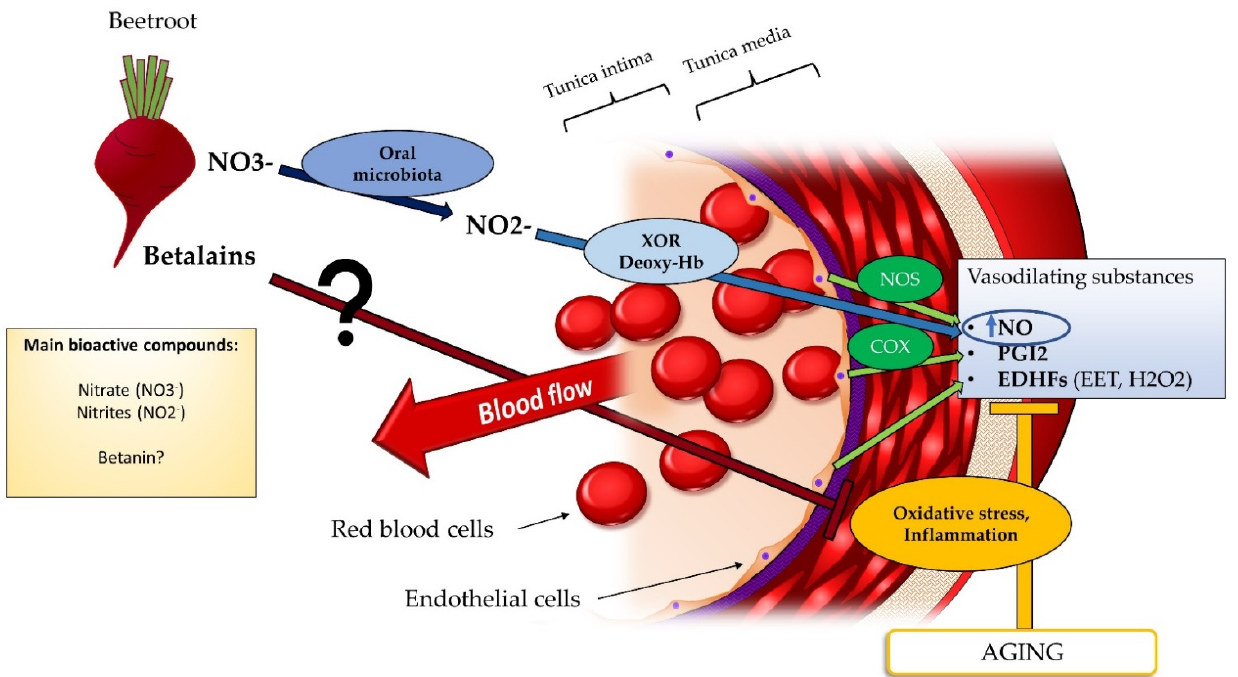
Figure 2. Schematic representation of the mechanism of action of beetroot in the increase of vascular function in older subjects. Endothelial cells produce vasodilating substances through different enzymes in response to physiological stimuli. Aging can be associated with high levels of oxidative stress and inflammation that cause an impairment of those vasodilating substances. Dietary NO3 − from nitrates rich vegetables, such as beetroot, can acutely contribute to replenish the pool of NO in case of impairment thanks to NOS independent pathway, such as XOR and Deoxy-Hb of red blood cells. Other beet bioactives (e.g., betanin, the main betalains contained in beetroot) can also be involved in these processes, through synergistic or independent effects. Legend: COX, cyclooxygenase Deoxy-Hb, deoxyhemoglobin; EDHFs, endothelial derived hyperpolarizing factors; EET, epoxyeicosatrienoic acid; H 2 O 2 , hydrogen peroxide; NO2 − , nitrites; NO3 − , nitrate; NO, nitric oxide; NOS, nitric oxide synthase; PGI2, prostacyclin2; XOR, xanthine oxidoreductase.